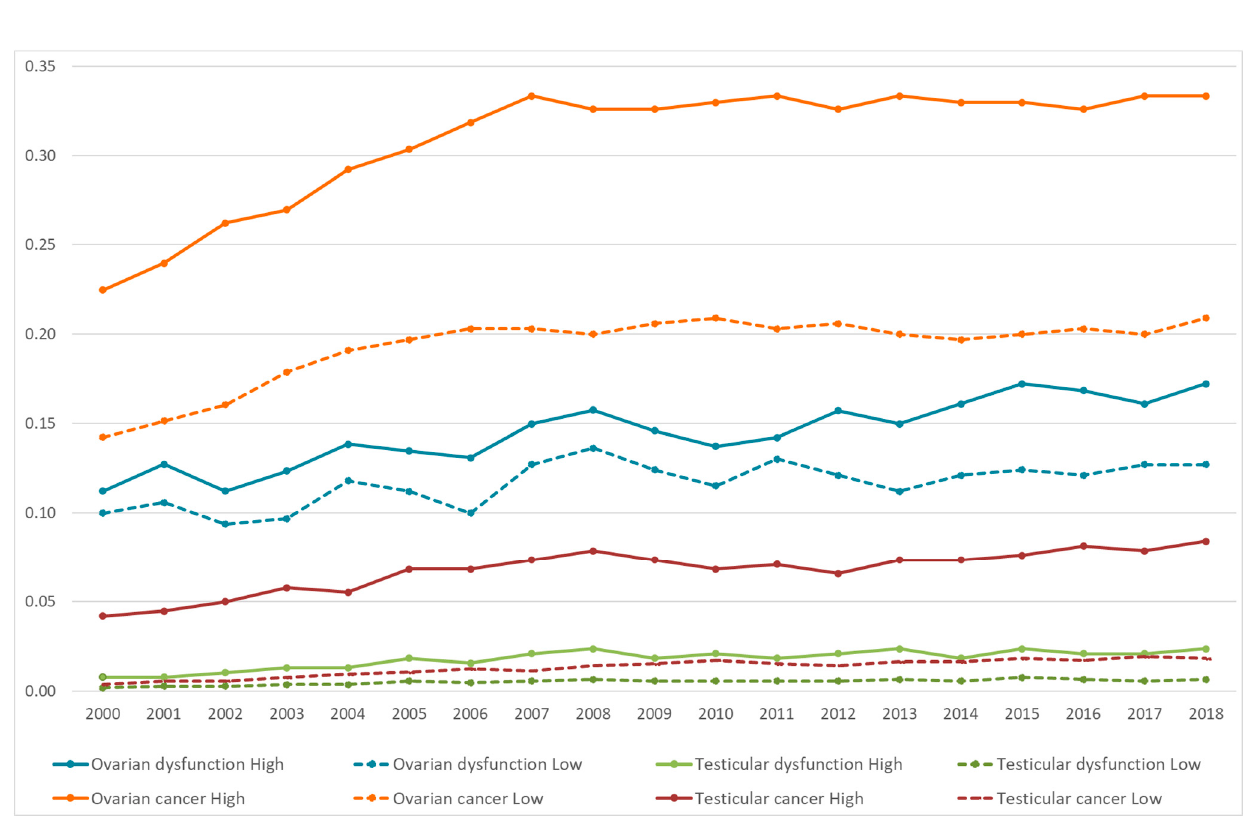
Figure 2. Distribution of the gonadal diseases (prevalence per 1000 inhabitants) as a whole and stratified by the geographical areas studied (high and low pesticide exposure).